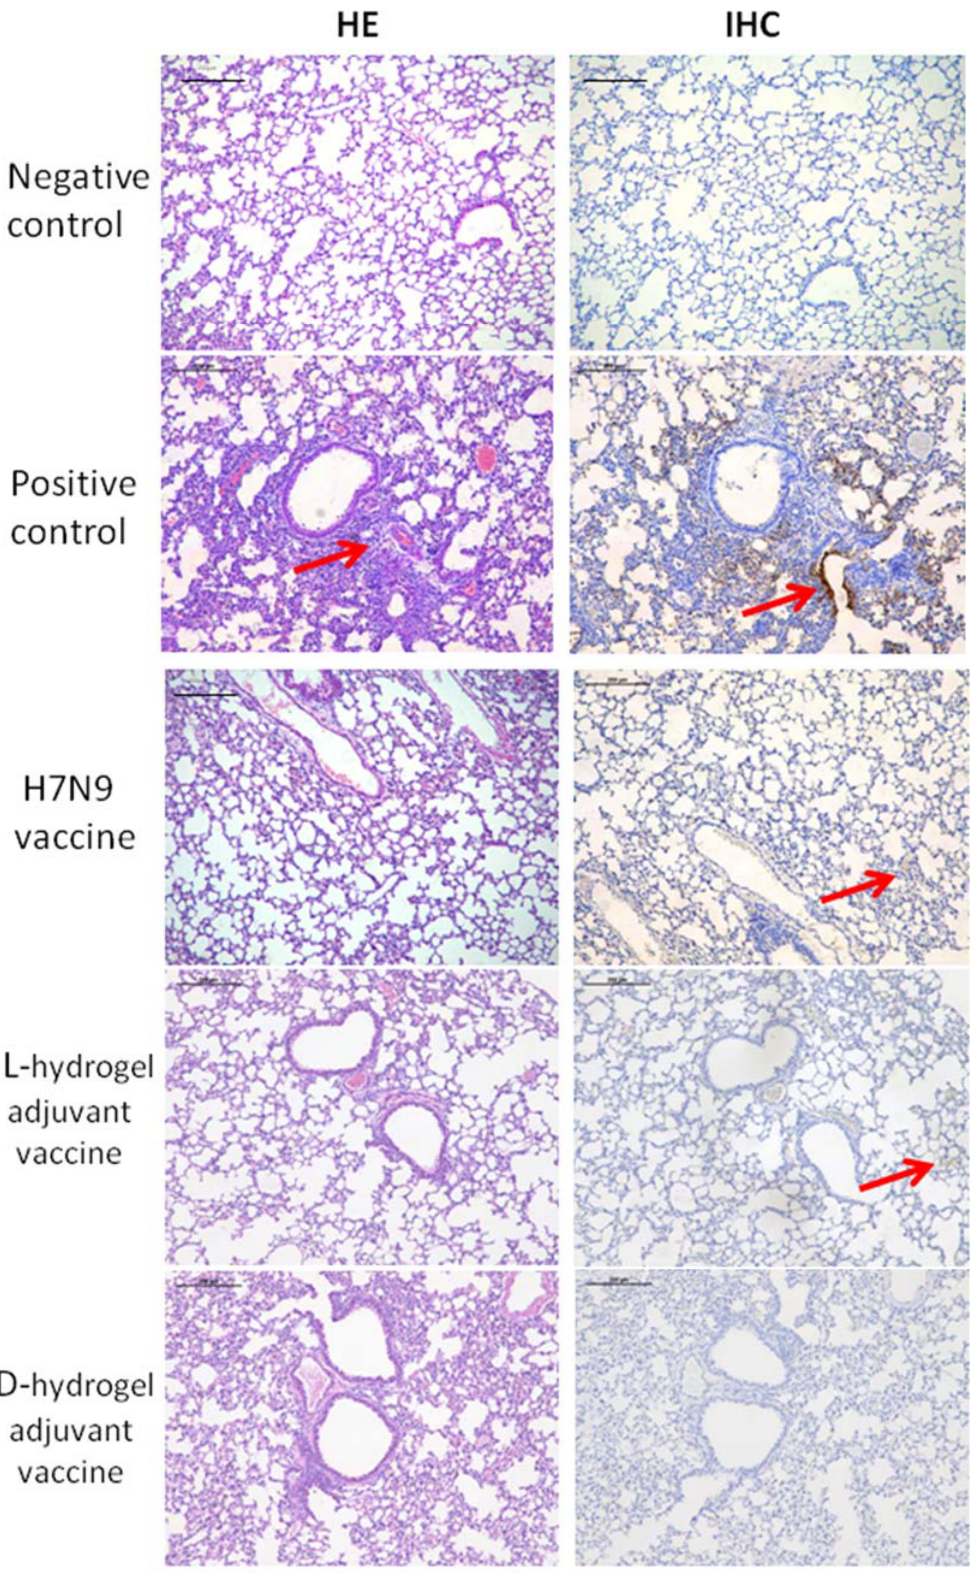
Figure 3. Representative HE ( left panel) and IHC ( right panel) staining images of lung tissues after various treatments. A hollow-like structure (red arrow) represents the tissue damage ( left panel). Tissue highlighted by polyclonal rabbit anti-H7N9 antibody reflecting the levels of H7N9 infection ( right panel). The scale bars in HE and IHC staining denote 200 μ m.